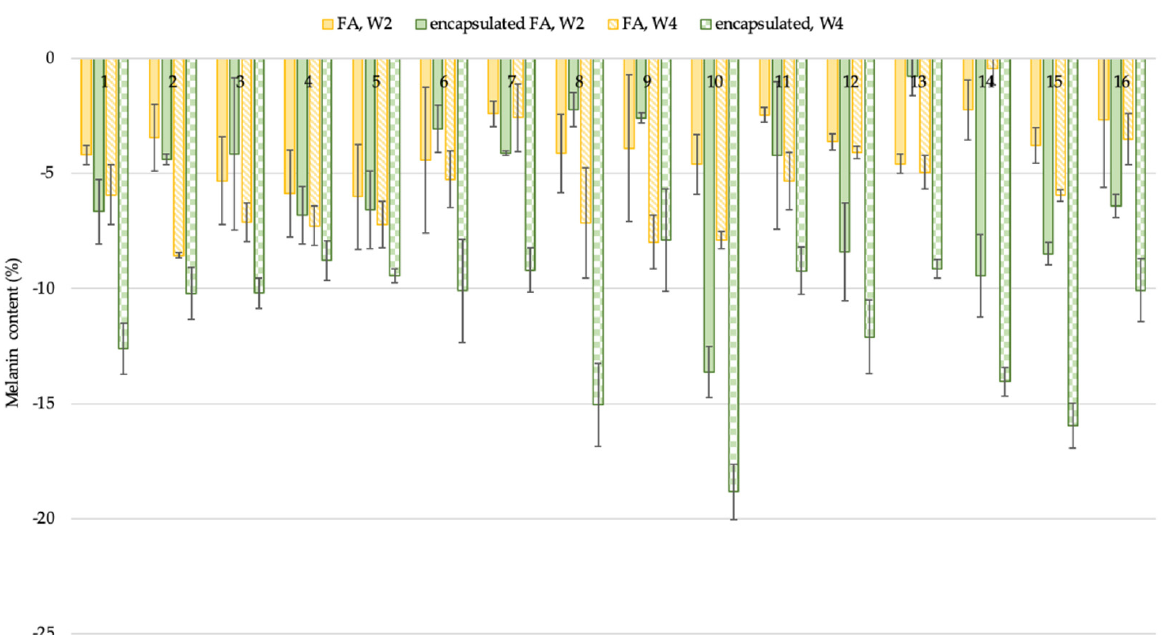
Figure 8. Percent of change in melanin content of each volunteer after application of FA and encap- sulated FA creams for 2 and 4 weeks.